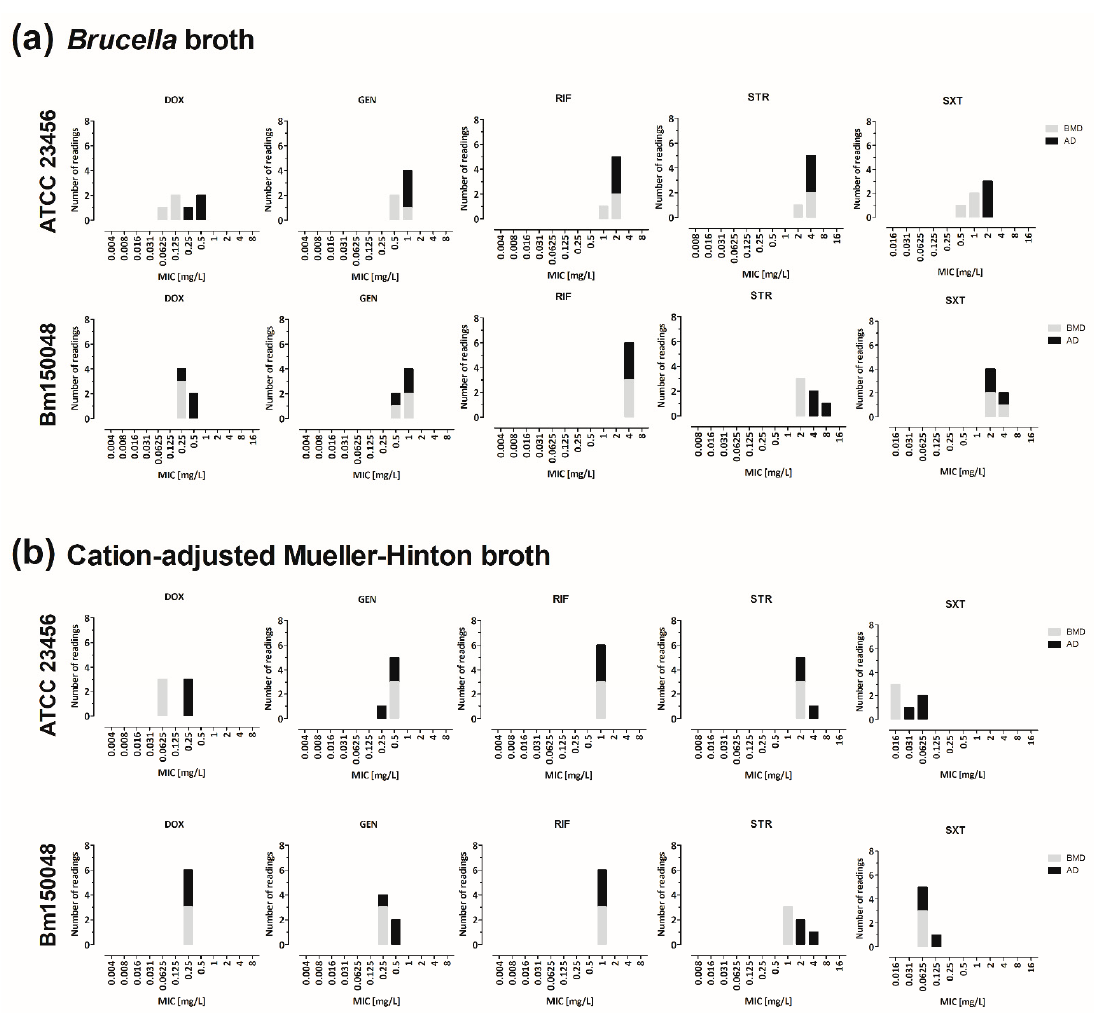
Figure 4. Comparison of BMD and AD using two different culture media (BB, CAMHB). B. melitensis reference strain ATCC 23456 and B. melitensis clinical isolate Bm150048 were used in triplicates to compare the MIC values obtained with BMD and AD when using BB ( a ) or CAMBH ( b ). The MIC values were obtained after incubation at 36 ± 1 ◦ C in a 5% CO 2 atmosphere for 48 h. The differences between the two methods were within two log 2 dilutions for both media using ATCC 23456 towards gentamicin, rifampicin, and streptomycin. For Bm150048, the following antimicrobials fulfilled this condition: doxycycline, gentamicin, rifampicin, and trimethoprim–sulfamethoxazole. The identical antimicrobials showed variances over more than two log 2 dilutions for the respective B. melitensis strain irrespective of the culture medium used: doxycycline and trimethoprim–sulfamethoxazole for ATCC 23456, and streptomycin for Bm150048. For both strains and both methods, the shift of trimethoprim–sulfamethoxazole’s MIC values using BB in comparison to CAMHB was visible, as observed before in this